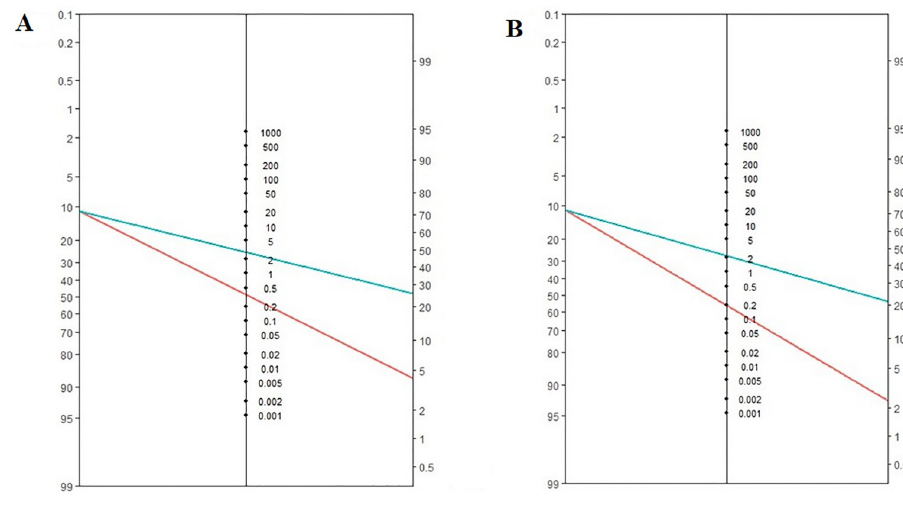
Fig 10. The Fagans’ nomograms for POD3 (A) and POD5 (B).